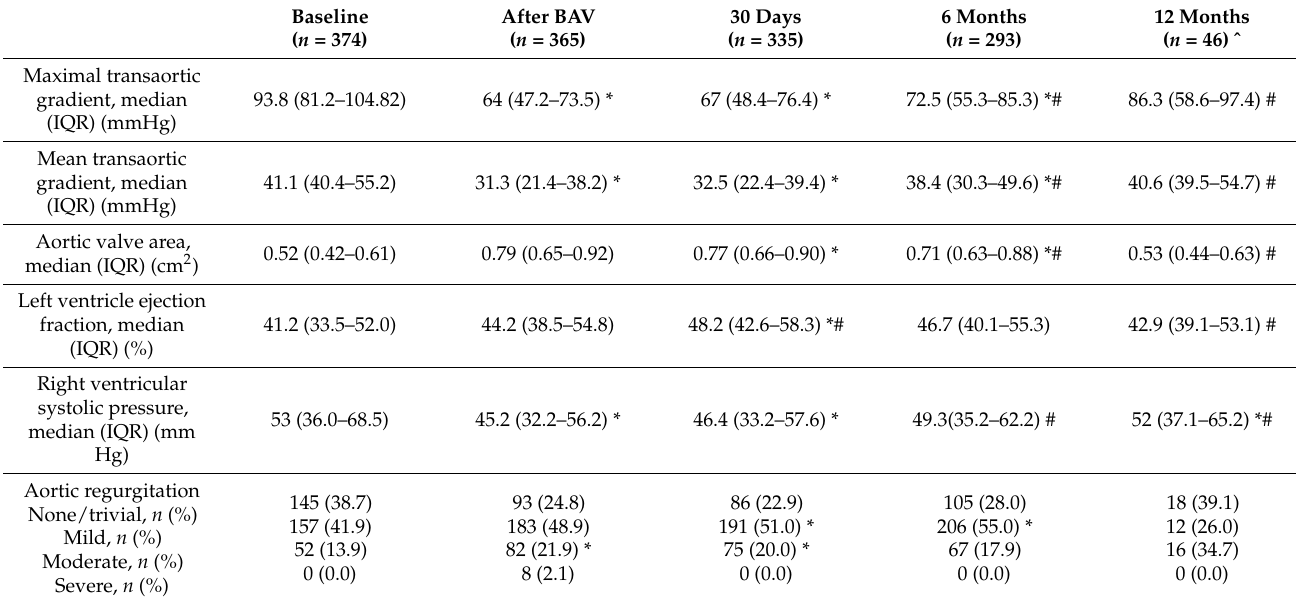
Table 3. Echocardiografic